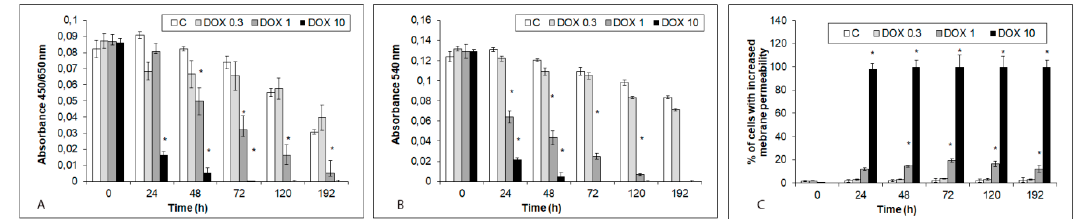
Figure 2. Effects of DOX (10, 1 and 0.3 µM) on viability, metabolism and membrane permeability of hiPCS-CMs during 192 h has measured by WST-1, Neutral red (NR) and ethidium bromide assays as described in Materials and methods section. ( A ) WST-1 assay ( B ) NR assay ( C ) ethidium bromide assay. Values represent means ± SD of at least three experiments * p < 0.05 compared to untreated control cells at the same treatment interval with one way-Anova test and Dunnett’s post test for multiple comparisons.